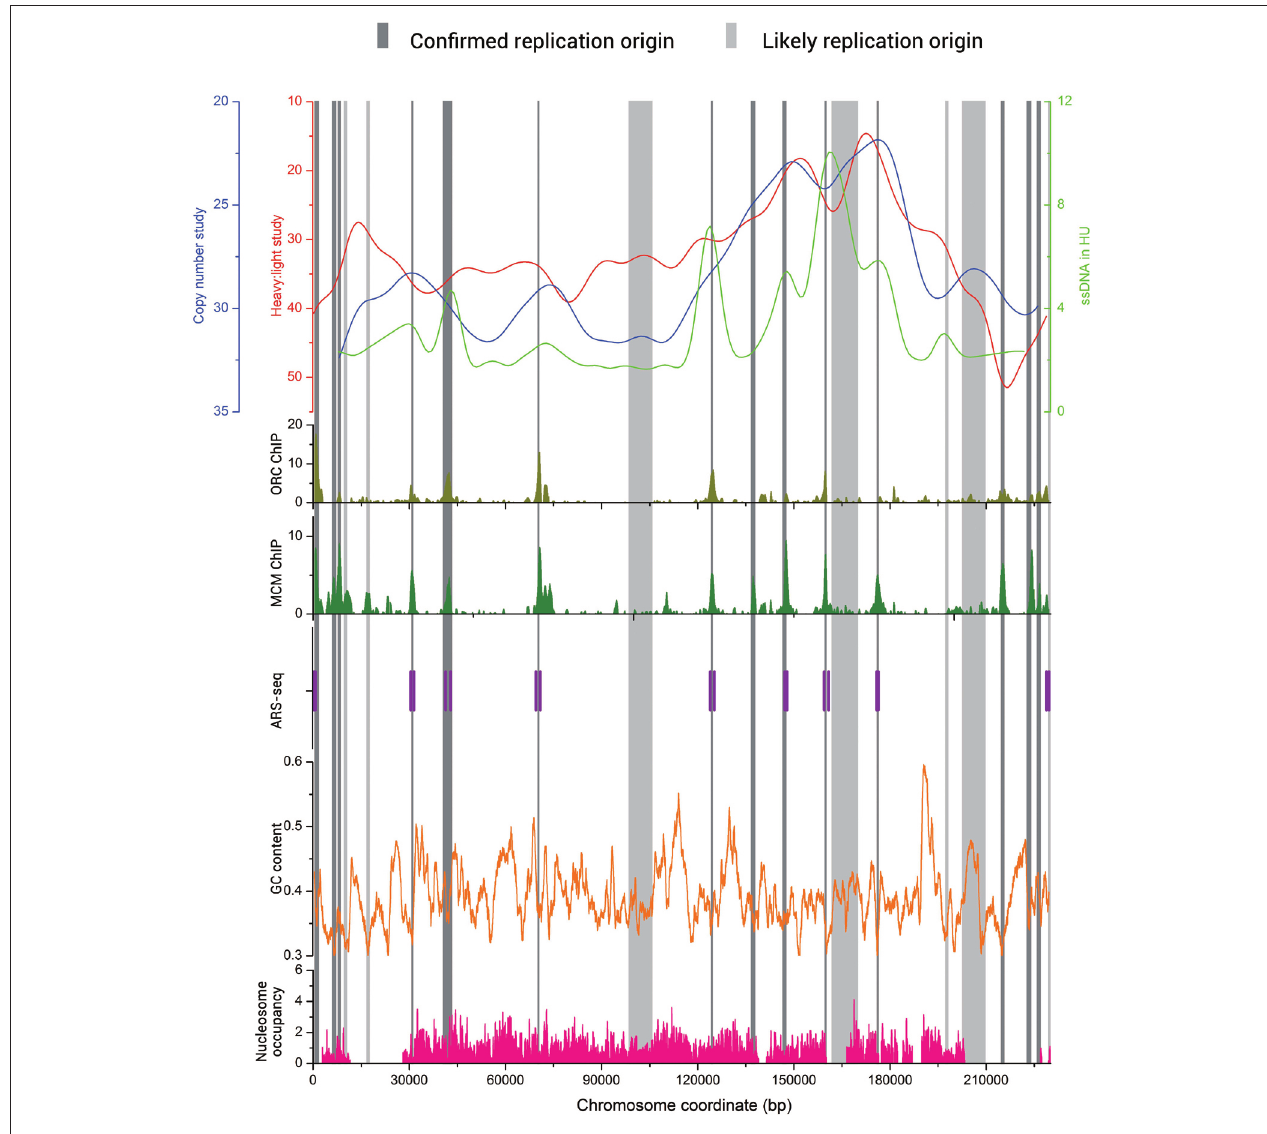
genome-wide data of ORC-ChIP (olive bars), MCM-ChIP (green bars), ARS-seq (vertical purple bars), GC content (orange line), and nucleosome occupancy (pink bars), respectively. The replication origin sites are indicated by vertical bars (dark gray for confirmed and light gray for